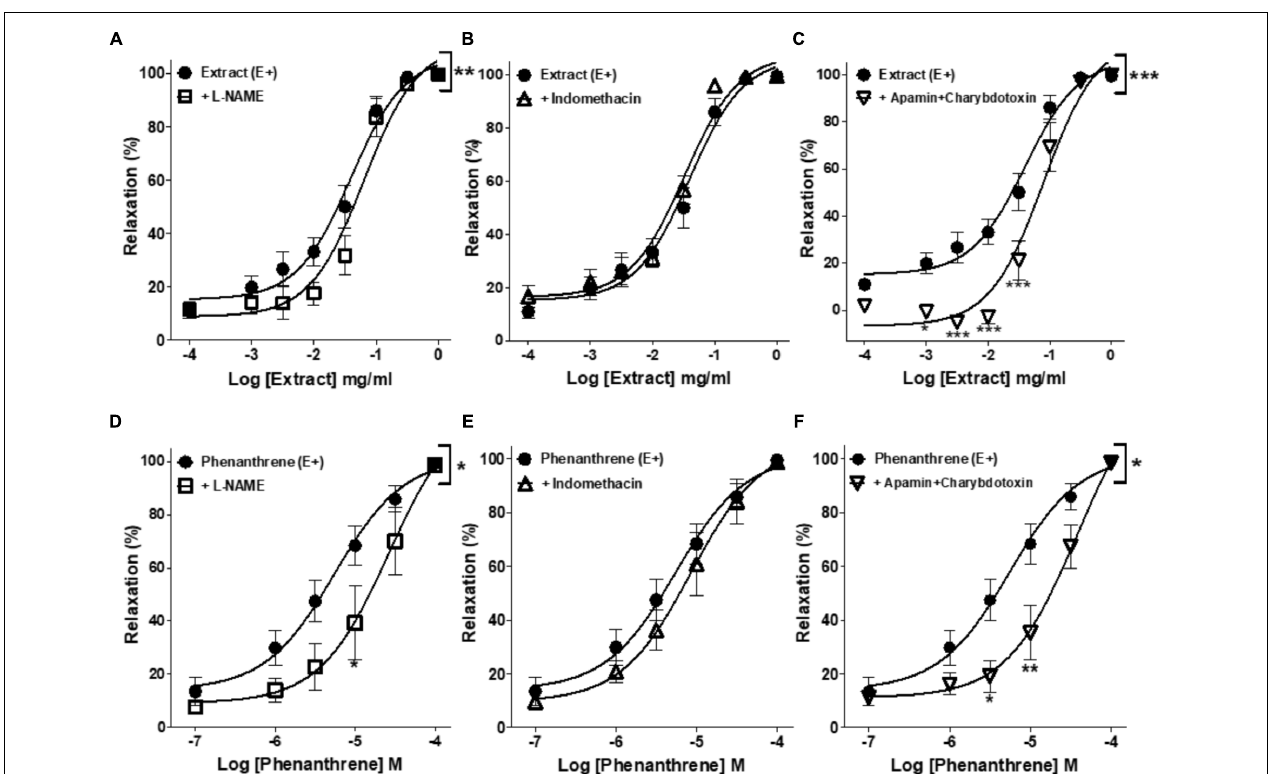
FIGURE 2 | Effects of different pharmacological inhibitors on EM extract or phenanthrene-induced relaxation. Relaxant effect of EM extract or phenanthrene on endothelium-intact mesenteric rings (E+) were measured in the absence [extract (E+) or phenanthrene (E+)] or presence of 10 − 4 M L-NAME (A,D) , 10 − 5 M indomethacin (B,E) or 10 − 7 M apamin plus charybdotoxin (C,F) . Relaxations are expressed as % contractions induced by 10 − 5 M PE. Values are means ± SEM of n individual arteries. ∗ p < 0.05, ∗∗ p < 0.01, ∗∗∗ p < 0.001 vs. Extract (E+) or phenanthrene (E+) ( n =